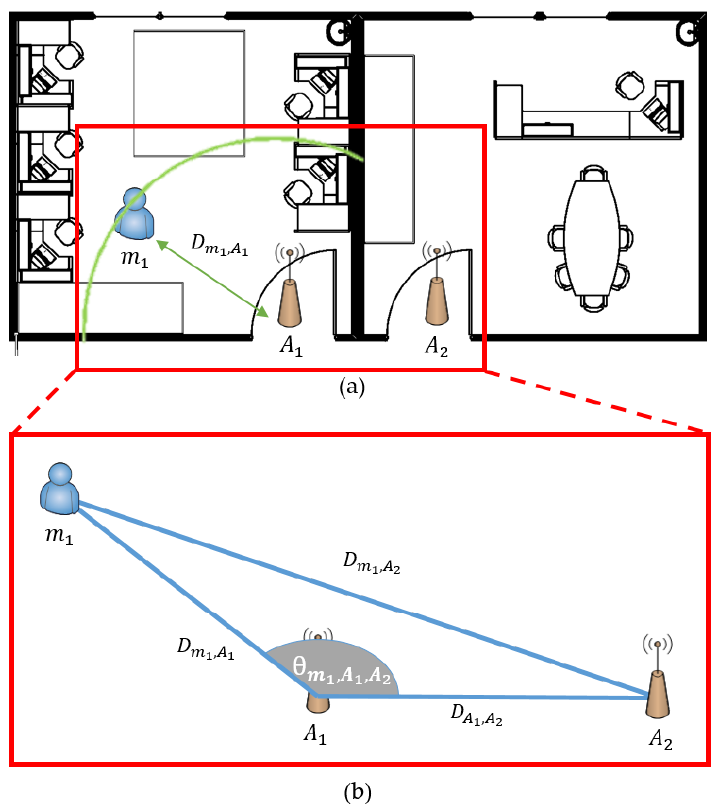
Figure 5. Precise position recognition using RSSI of LF/RF signal: ( a ) distance awareness using LF; and ( b ) angle awareness using BLE.